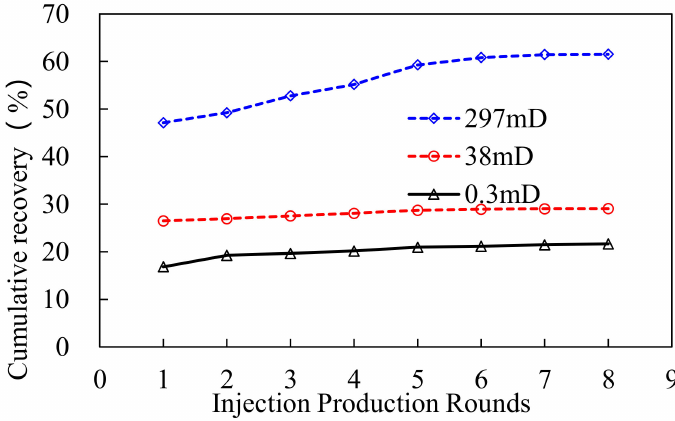
Figure 8. Acquisition degree of different permeabilities at eight